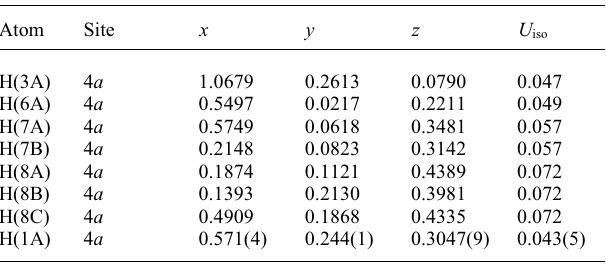
Table 2. Atomic coordinates and displacement parameters (in Å 2 )